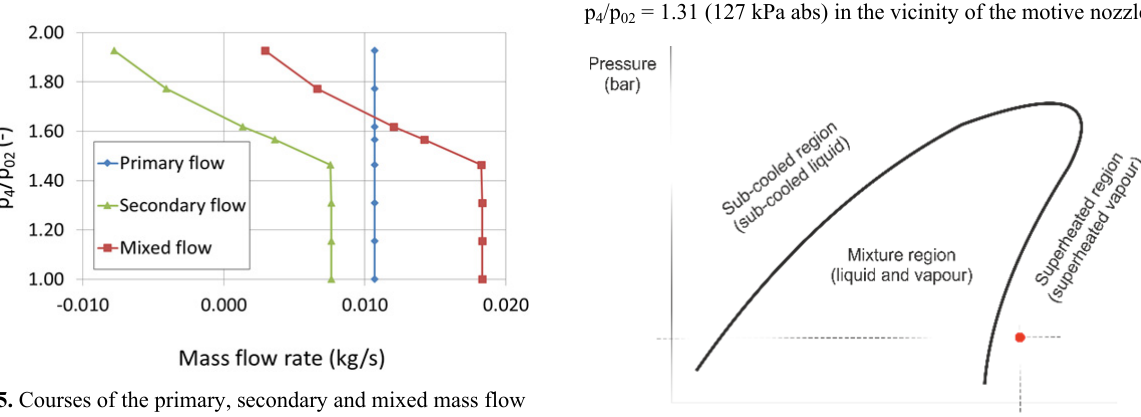
Fig. 8. Contours of temperature for relative back-pressure